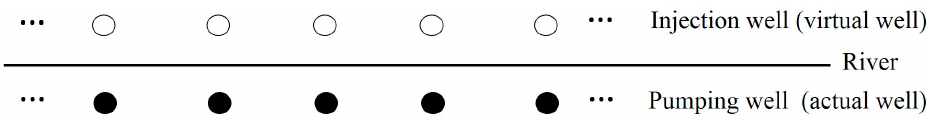
Figure 2. Schematic of Mirror-Image Method of the scenario of a well group paralleling to the river line.